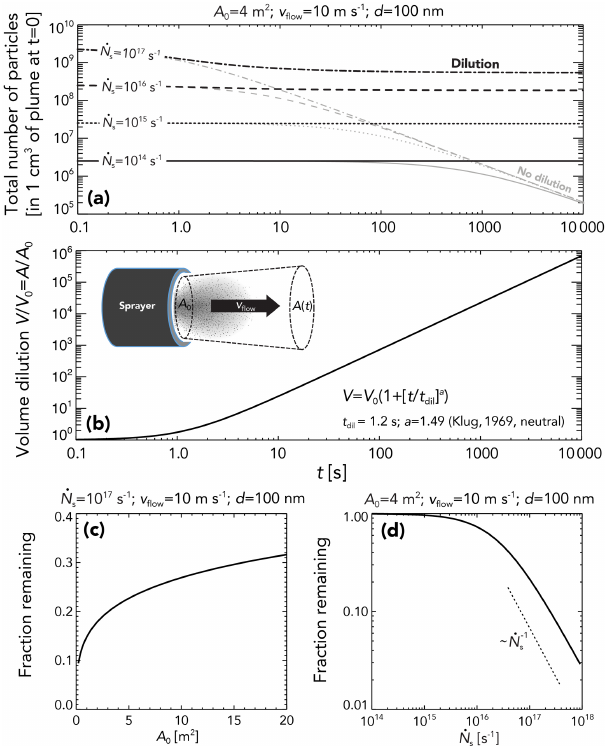
Figure 11. Effects of coagulation on the concentration of particles at time t downstream of a hypothetical sprayer system with cross- sectional area A = 4m − 2 and flow rate of air across the sprayer v flow = 10ms − 1 . Here, a single particle diameter d = 100nm is assumed, and solutions follow Turco and Yu (1997). (a) Particle concentrations with dilution proceeding according to the dispersion rates for neutral conditions are from Klug (1969), as reproduced in Seinfeld and Pandis (2006; their Table 18.3). Concentrations in the absence of plume dilution are shown for comparison (gray), indi- cating major losses and eventual asymptotic solution. (b) The ratio of volume V to initial volume V 0 increases super-linearly with time with a dilution timescale t dil = 1 . 2s. (c) Fraction of particles re- maining at t = 10000s as a function of initial plume cross-sectional area A 0 for spray rate ˙ N s = 10 17 s − 1 . (d) Fraction of particles re- maining at t = 10000s as a function of ˙ N s for A 0 = 4m 2 . The dot- ted line shows the scaling such that the fraction remaining decreases at the same rate as ˙ N s increases, i.e., there is no increase in far-field particle concentration with increasing sprayer